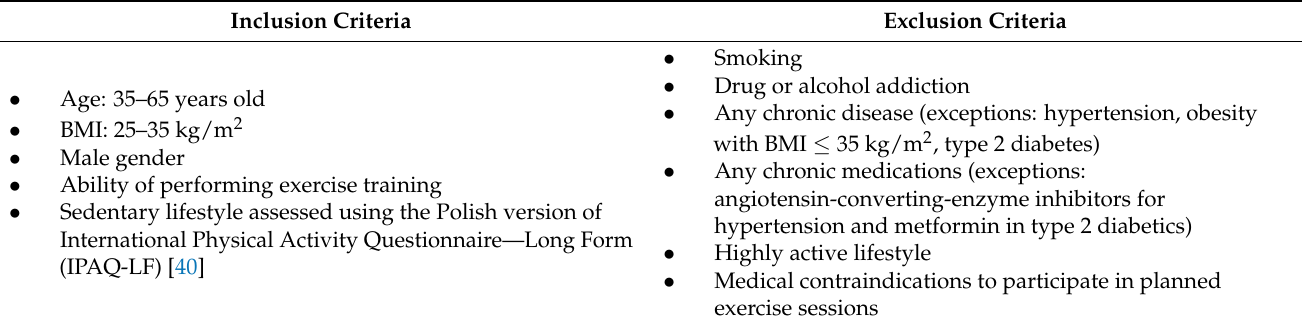
Table 1. Inclusion and exclusion criteria for study